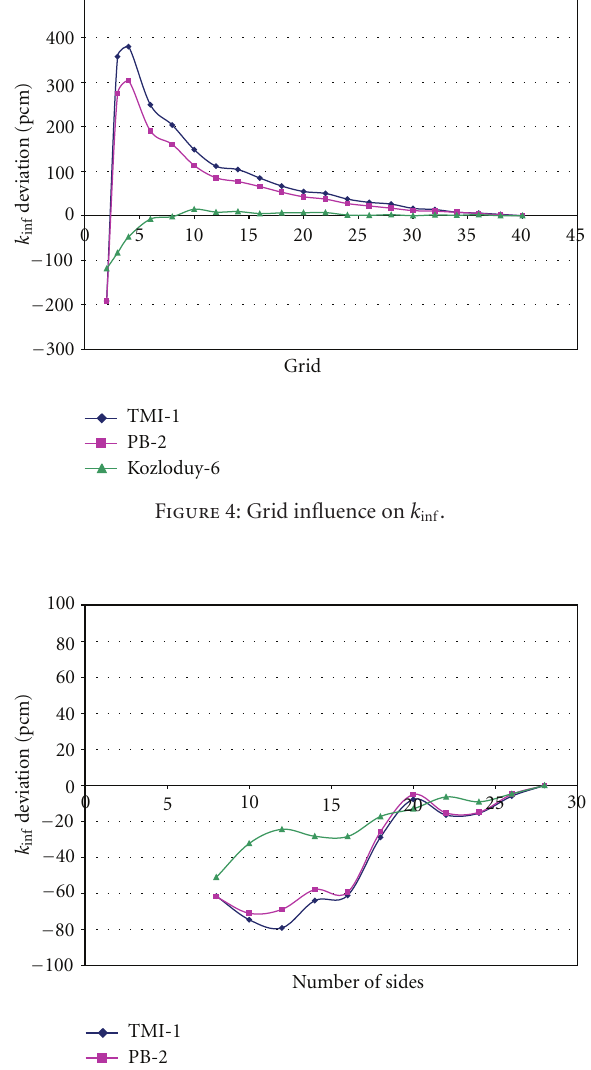
Table 4: TMI-1 fuel pin—NEWT and HELIOS results for reference